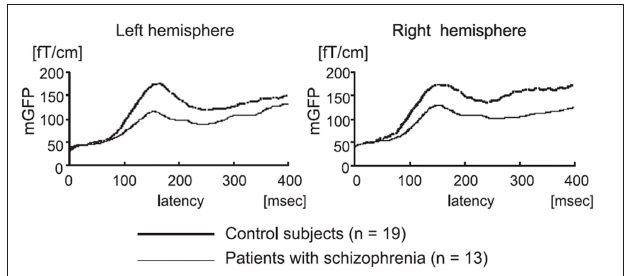
Figure  | Mismatch negativity (MMN) in healthy control participants and in patients with schizophrenia. Changes in grand magnetic field power (mGFP) over auditory cortex in response to a deviant stimulus (phoneme change) are significantly reduced in patients with schizophrenia bilaterally. Reproduced, with permission, from Yamasue et al. (2004).